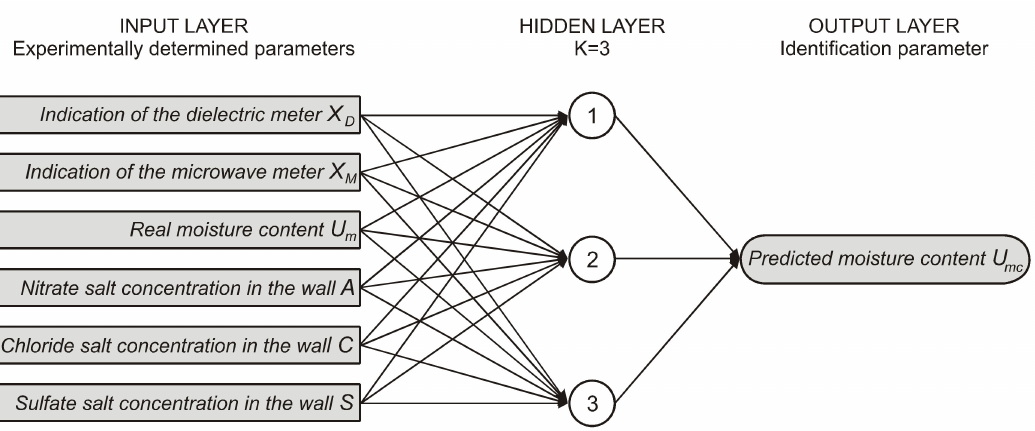
Figure 2. Structure of the artificial neural network used in [29].